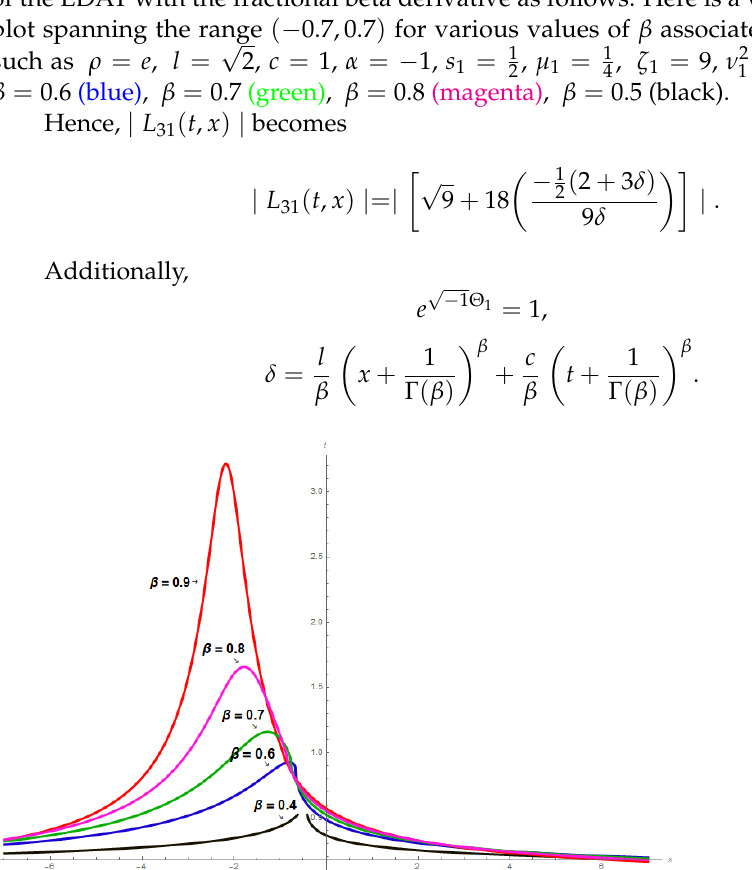
Figure 4. The 2D graphs of solitary-wave solution, i.e., | L 31 | across different values of β . Figure 5: This illustration portrays a realistic representation of | L 6 ( t , x ) | , which is linked to the category of dark solitary-wave solutions. Here is a visual showing a 3D plot spanning the range ( − 0.8, 0.8 ) for various values of β associated with parameters, such as √ ρ = e , l = 2, c = 1, α = − 1, s 1 = 1 , µ 1 = 1, ζ 1 = 2, ν 1 = 3, β = 2